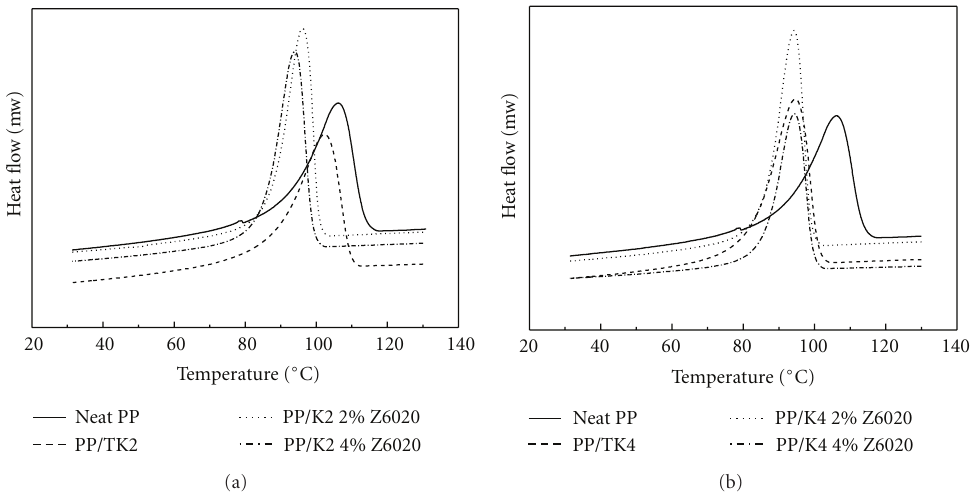
Figure 7: DSC thermograms of PP composites containing (a) 2 phr and (b) 4 phr of kaolinite treated with 2% and 4% of silane, cooled from the melt at 20 ◦